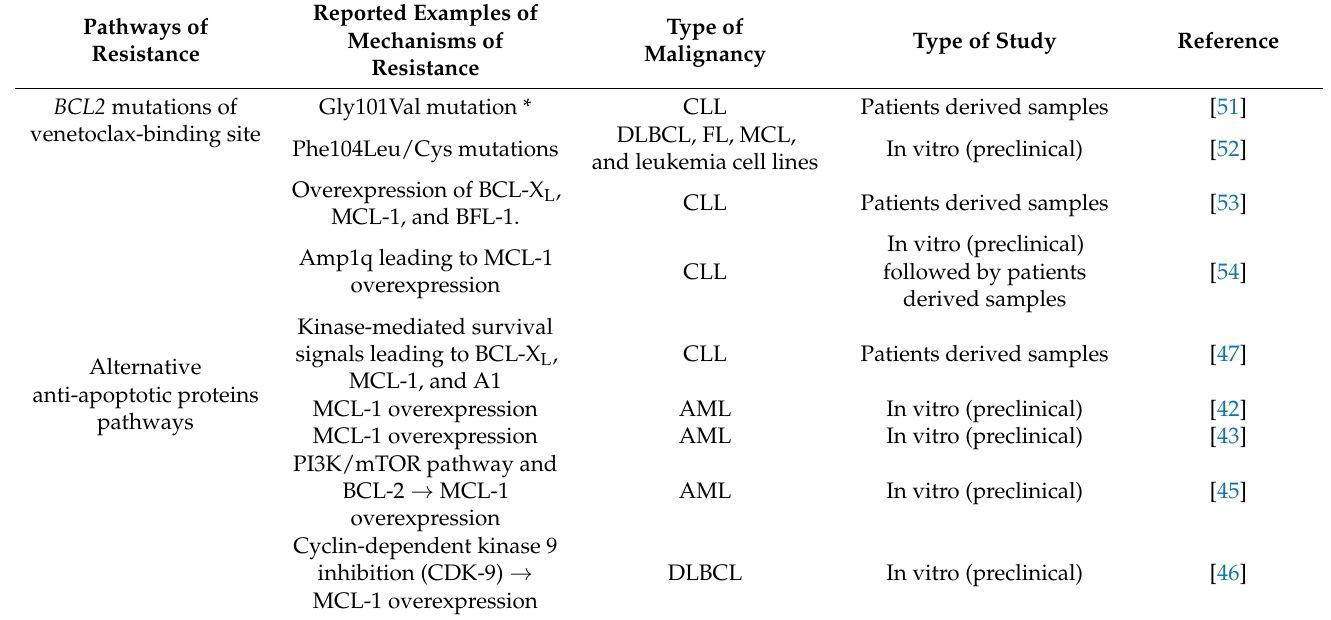
Table 1. Summary of resistance mechanisms to venetoclax